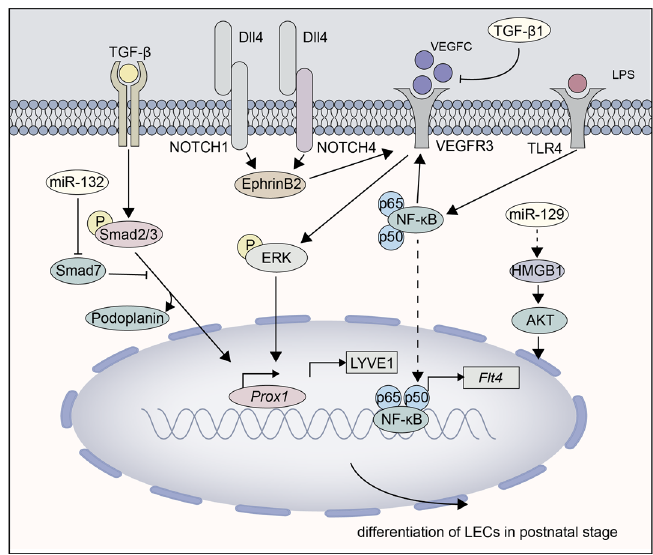
Figure 3. The molecular pathways responsible for LEC differentiation during adulthood stage. (1) The inhibition of TGF- β 1 and activation of VEGF-C promote Podoplanin and Prox1 expressions in different levels. (2) NF- κ B, p50, and p65 regulate the transcription of VEGFR-3 in both LECs and macrophage-derived LECPs in a mouse peritonitis model. (3) LPS-activation of TLR4/NF- κ B pathway influences the downstream targets of the VEGF-C/VEGFR3 pair, inducing myeloid cells to differentiate into M-LECP. (4) VEGF-C-treated adipose-tissue-derived stem cells were proved to promote lymphangiogenic function by regulating TGF- β /Smad signaling. (5) Similar with the embryonic stage, Dll4/NOTCH1/NOTCH4 axis regulates the expression of VEGFR3 via EphrinB2 /Ras/MAPK signaling pathway. (6) miR-129/HMGB1/AKT signaling in adipose-tissue-derived stem cells stimulates the lymphangiogenesis.